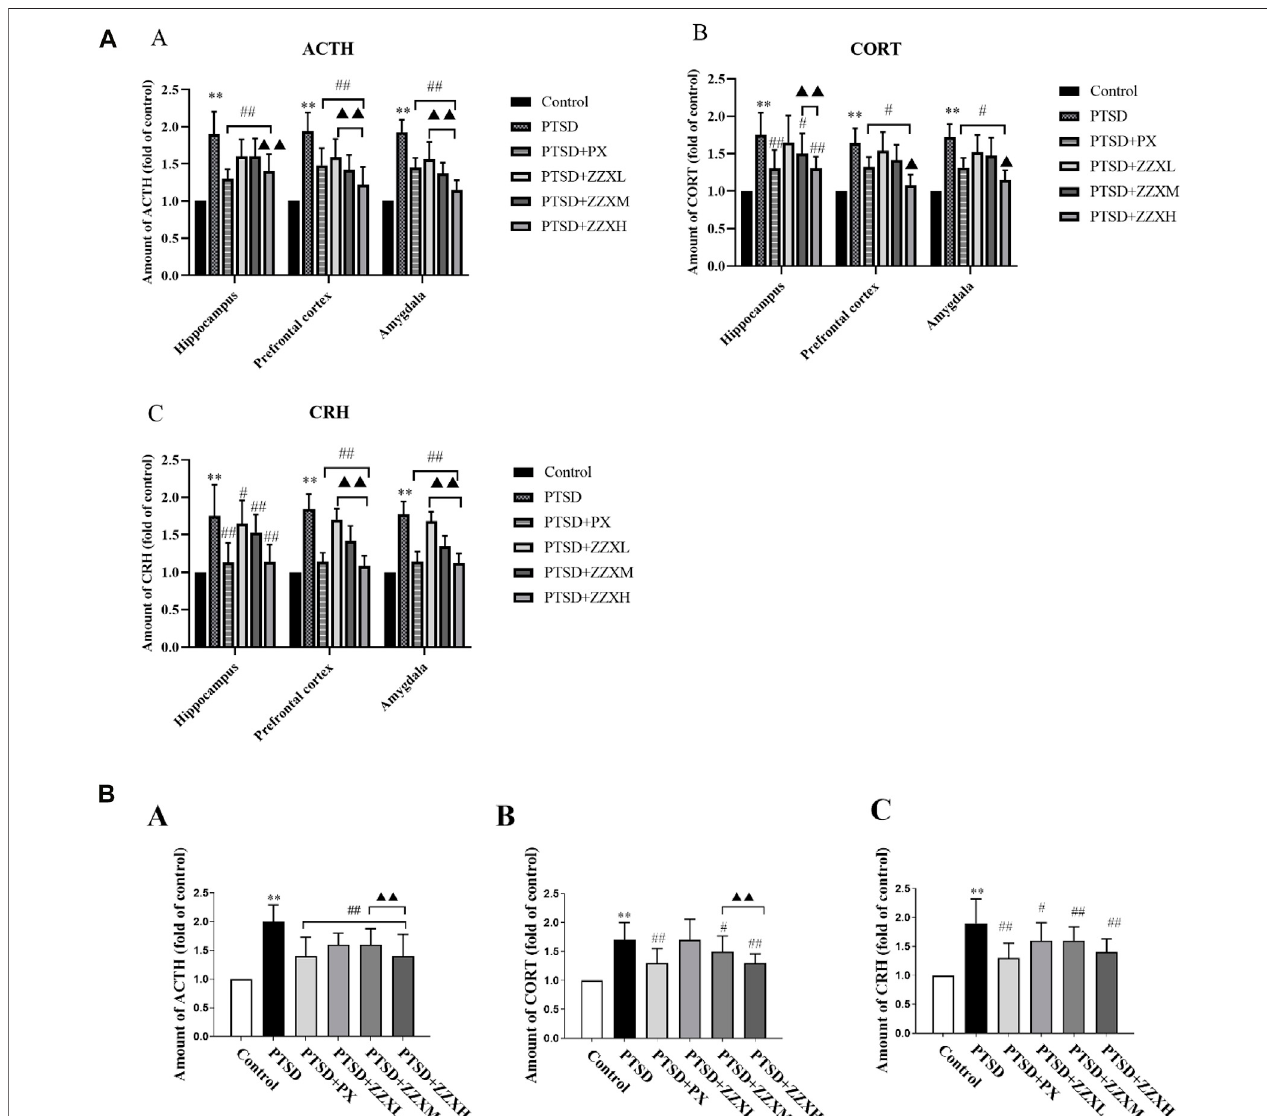
FIGURE 8 | (A) Effects of ZZX treatment on ACTH, CORT, and CRH (A, B, C) levels in different brain regions of mice. Values are expressed as (mean ± SEM, n (cid:2) 10 – 15). * p < 0.05, ** p < 0.01 vs control group. # p < 0.05, ## p < 0.01 vs PTSD group. ▲ p < 0.05, ▲▲ p < 0.01 vs ZZXM group. (B) Effects of ZZX treatment on ACTH, CORT, and CRH (A, B, C) levels in serum of mice. Values are expressed as (mean ± SEM, n (cid:2) 10 – 15). * p < 0.05, ** p < 0.01 vs control group. # p < 0.05, ## p < 0.01 vs PTSD group. ▲ p < 0.05, ▲▲ p < 0.01 vs ZZXM group.